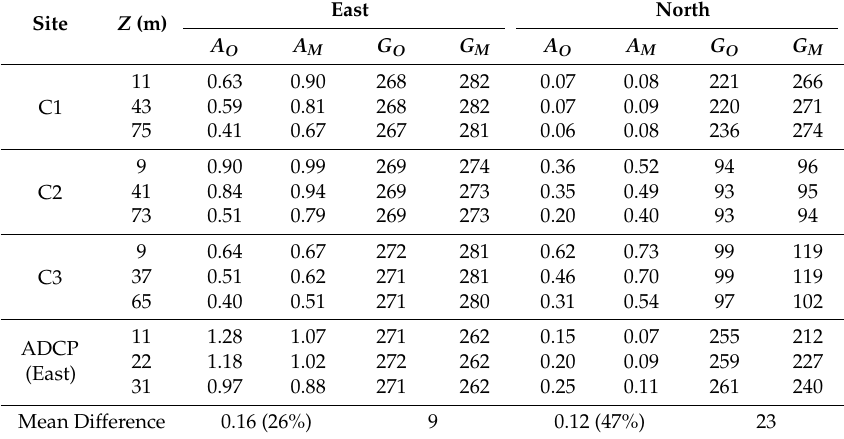
Table 6. Observed (subscript O) and modelled (subscript M) amplitude ( A , m · s − 1 ) and phase ( G , ◦ relative to UTC) of the east and north components of tidal velocity for the S 2 tidal constituent. Results are presented for near-surface, mid-depth and near-bed bins, with the relevant depth, Z (m), noted for